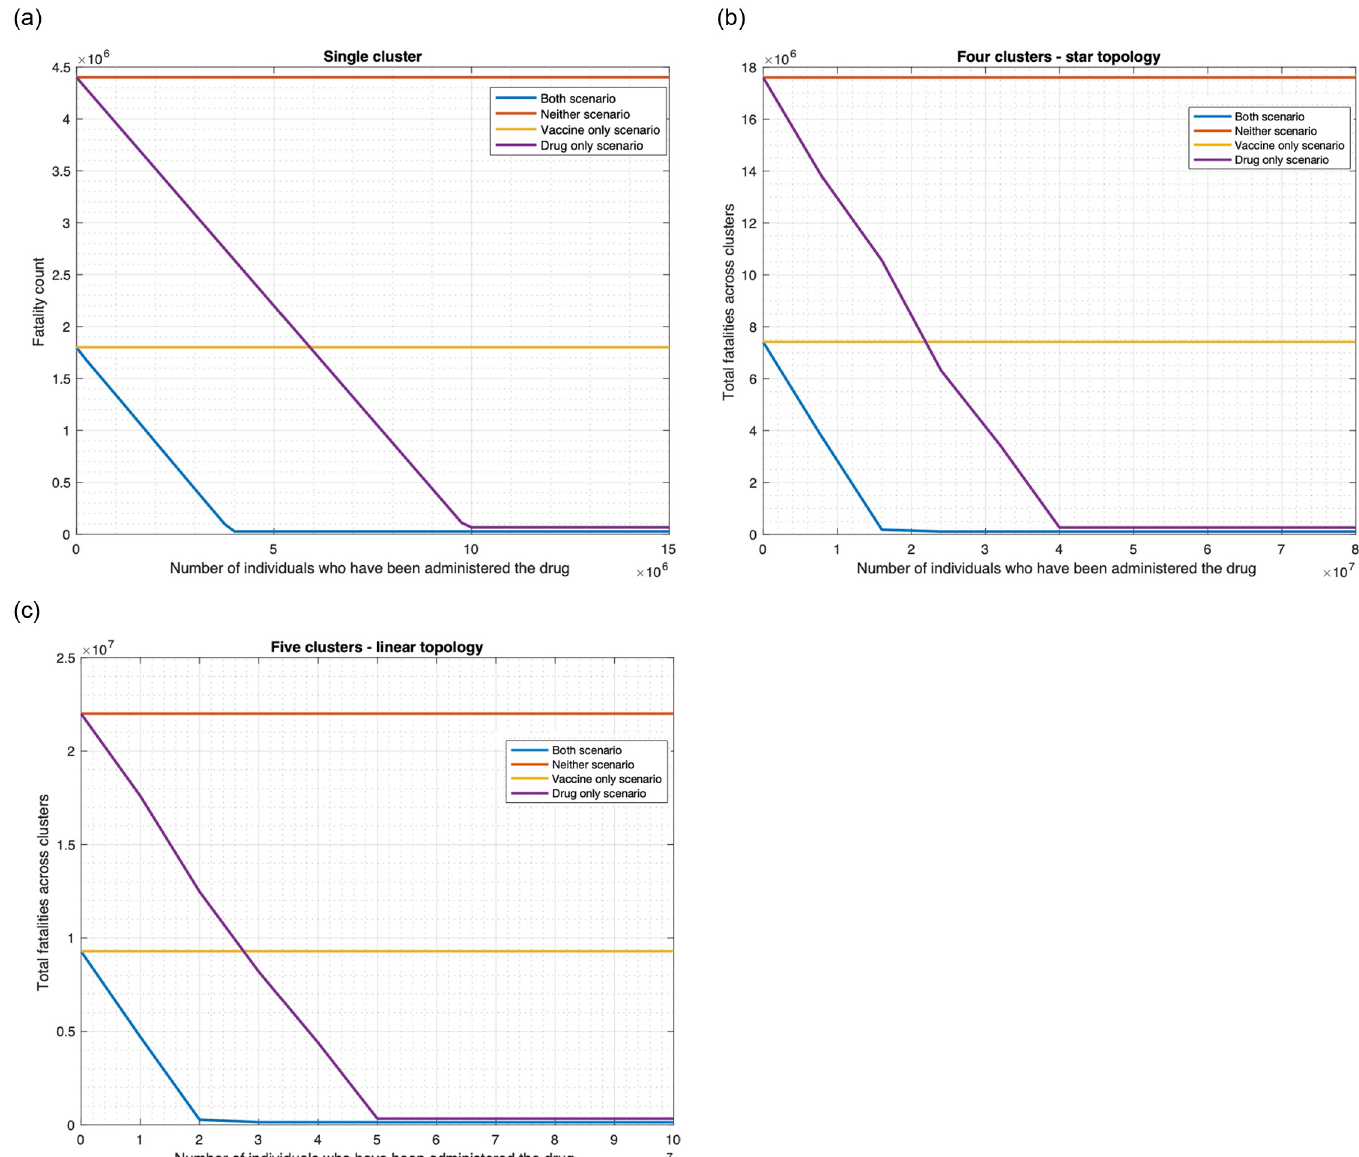
Fig 16. Relationship between fatalities and antiviral drug availability. (a) Single cluster. (b) Star topology. (c) Linear topology.